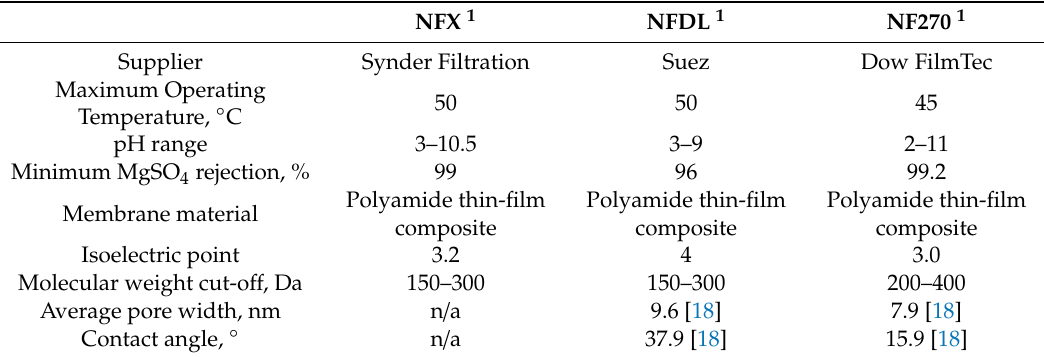
Table 2. Properties of the NF membranes were